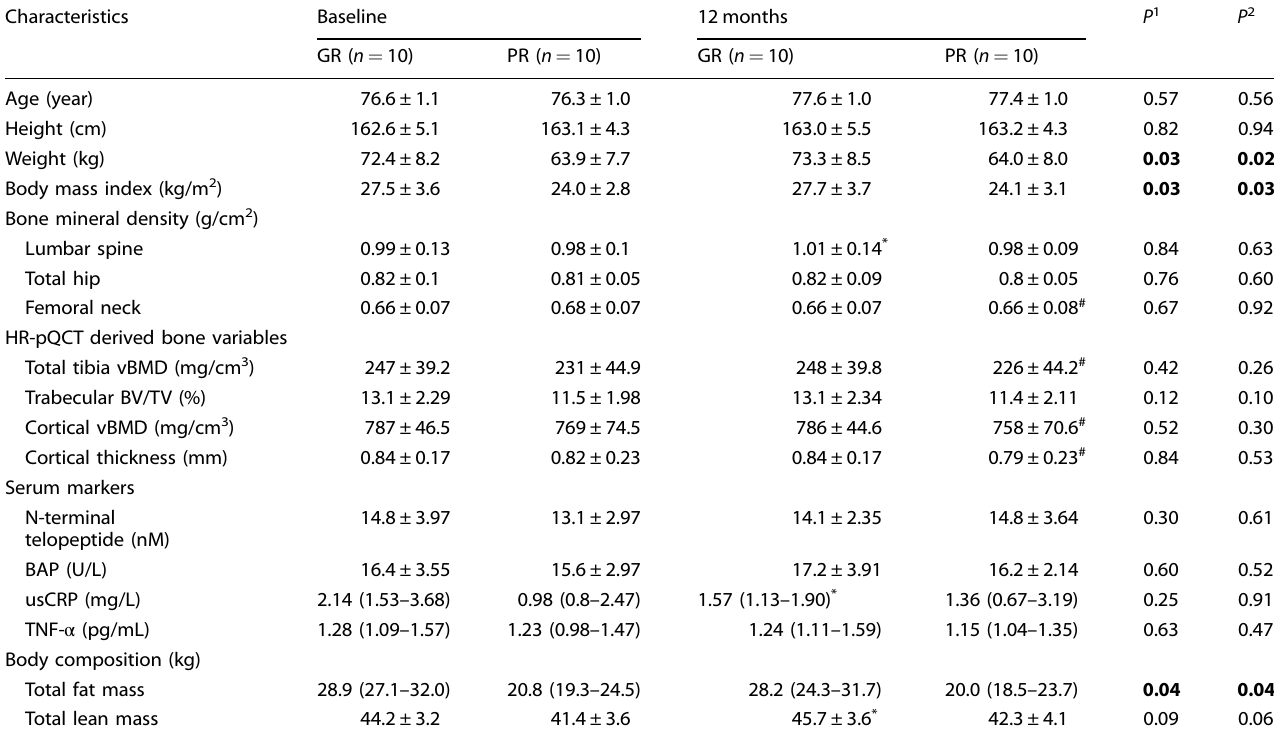
Table 1. Comparions of characteristics in the GR and PR groups at baseline and 12